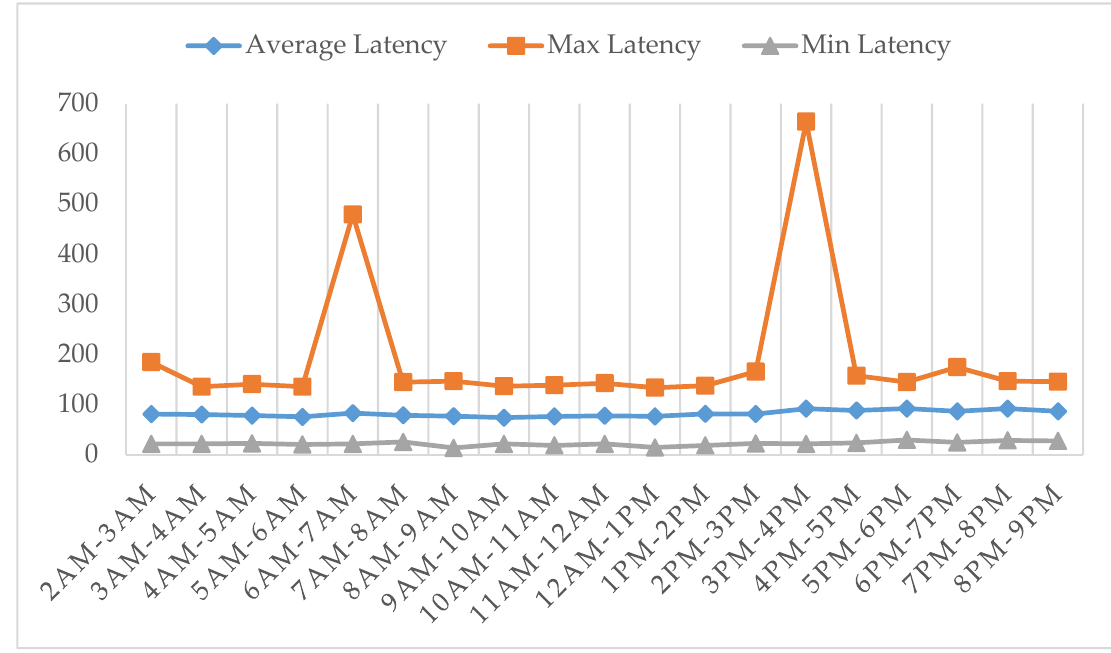
Figure 12. Latency evaluation for Azure IoT Hub.